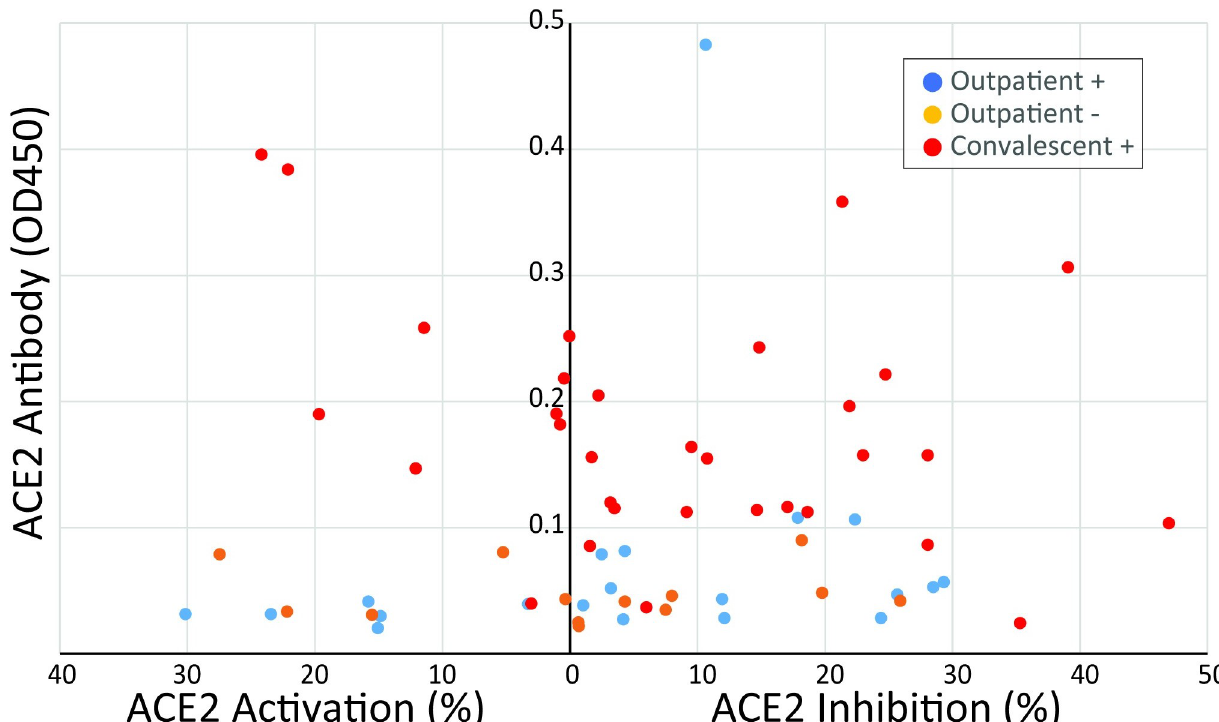
Fig 7. Inhibition of ACE2 activity by plasma. The abundance of the ACE2 antibody is plotted against the change in ACE2 activity after addition of plasma.